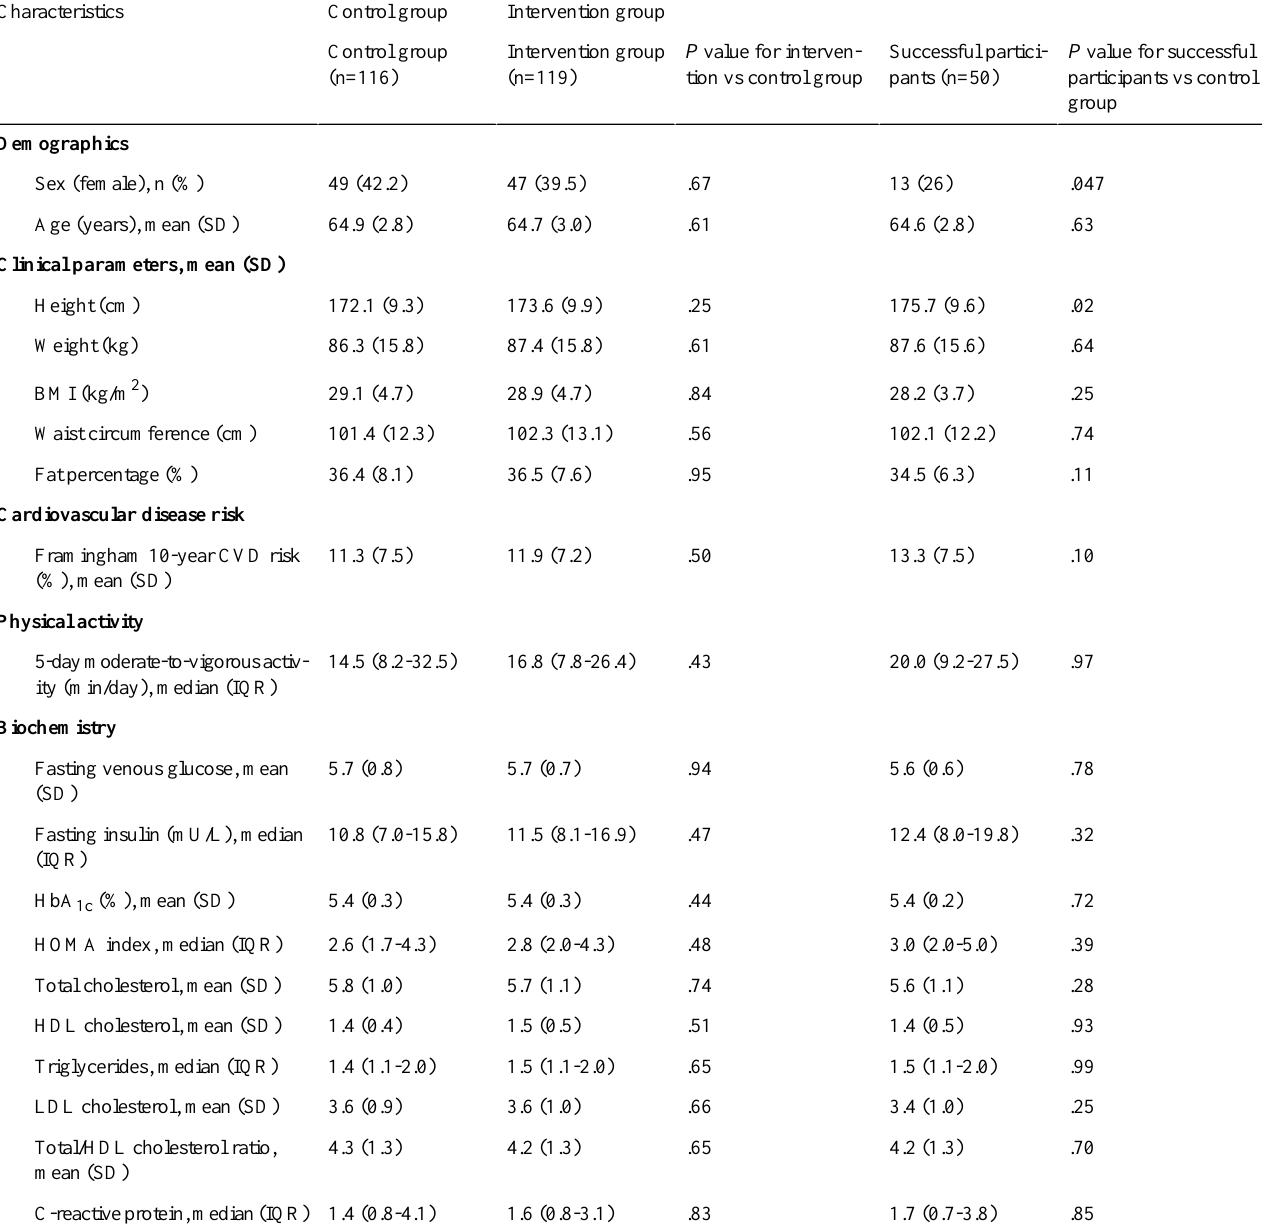
Intervention groupControl groupCharacteristics